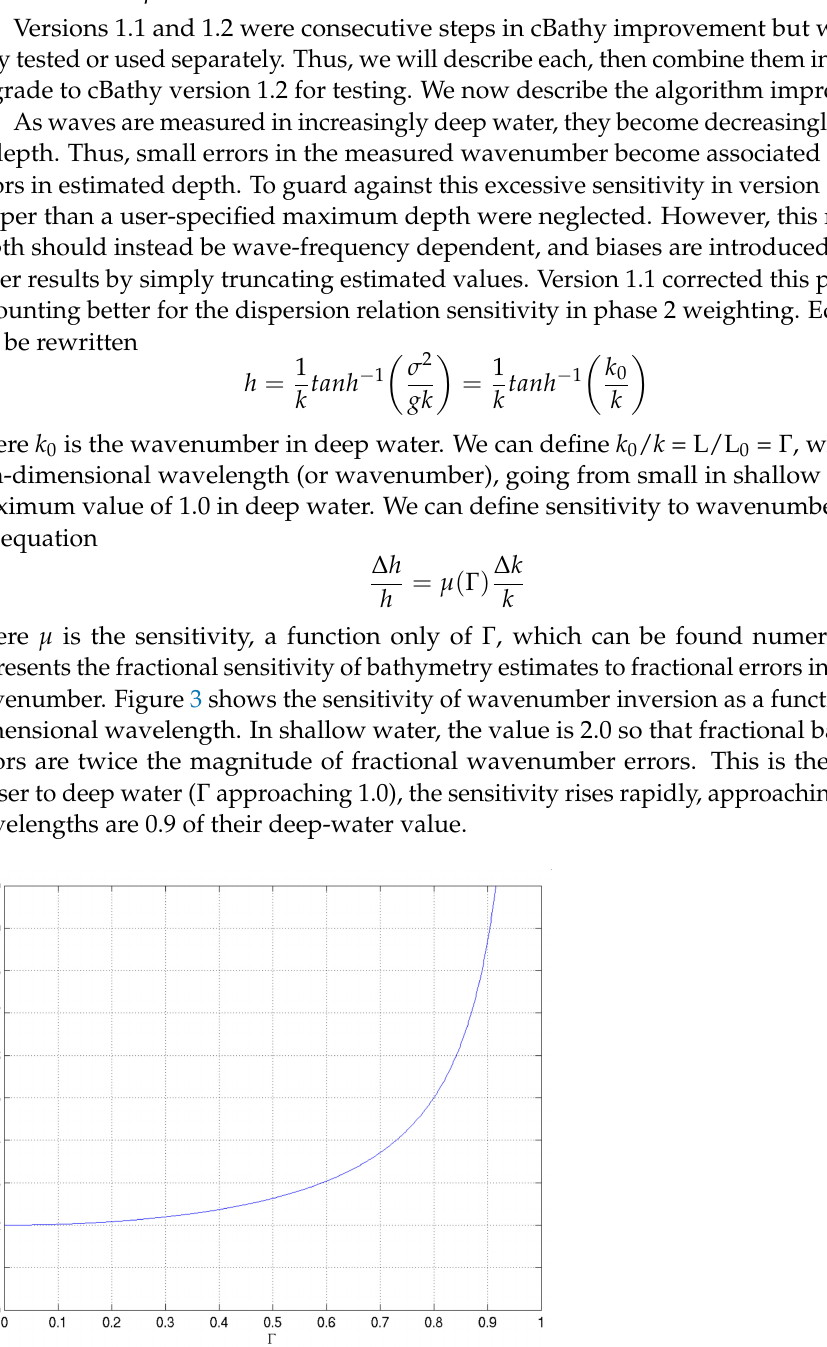
Figure 3. Sensitivity of the dispersion relationship showing the increasing sensitivity of the inversion process as deep water is